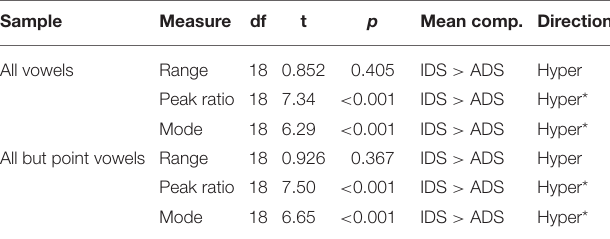
TABLE 7 | Paired-samples t -test comparing dynamic measures of VHH in IDS and ADS for all vowels. Sample Measure df t p Mean comp.